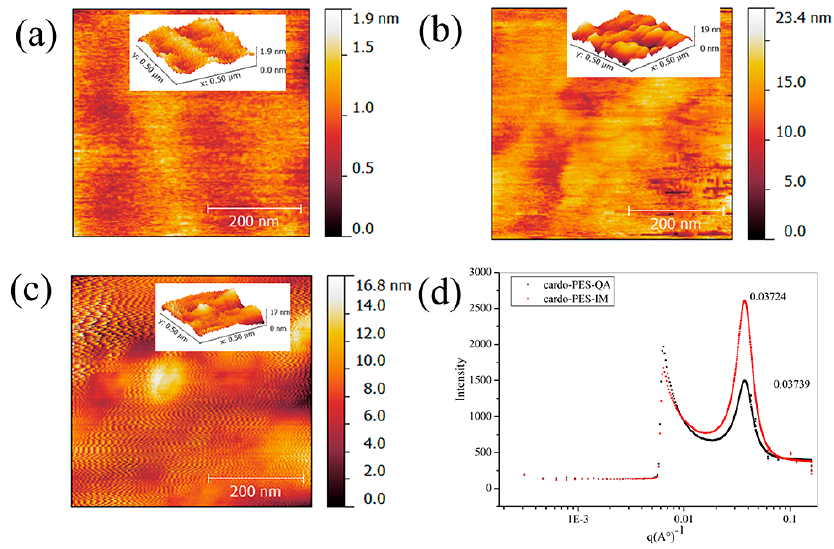
Figure 7. AFM phase images of the cardo-PES-QA ( a ) and cardo-PES-IM (b, c) membranes. ( b ) Membrane equilibrated at 50% RH, and ( c ) fully wet membrane dried at 50 °C for 30 min. Inset pictures indicate the corresponding 3D images. ( d ) SAXS profiles of the multiblock copolymer AEMs.